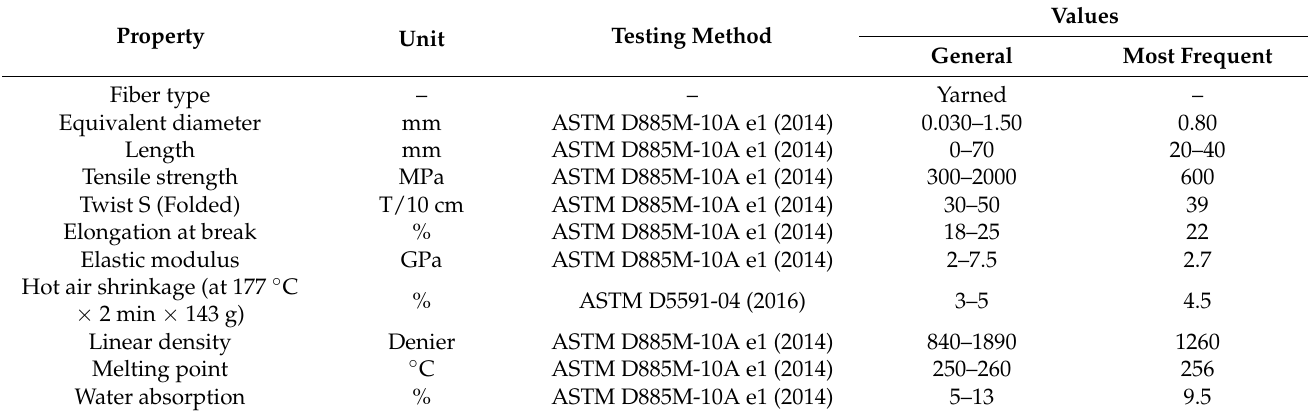
Table 2. Physical and mechanical characteristics of WTTF [40].